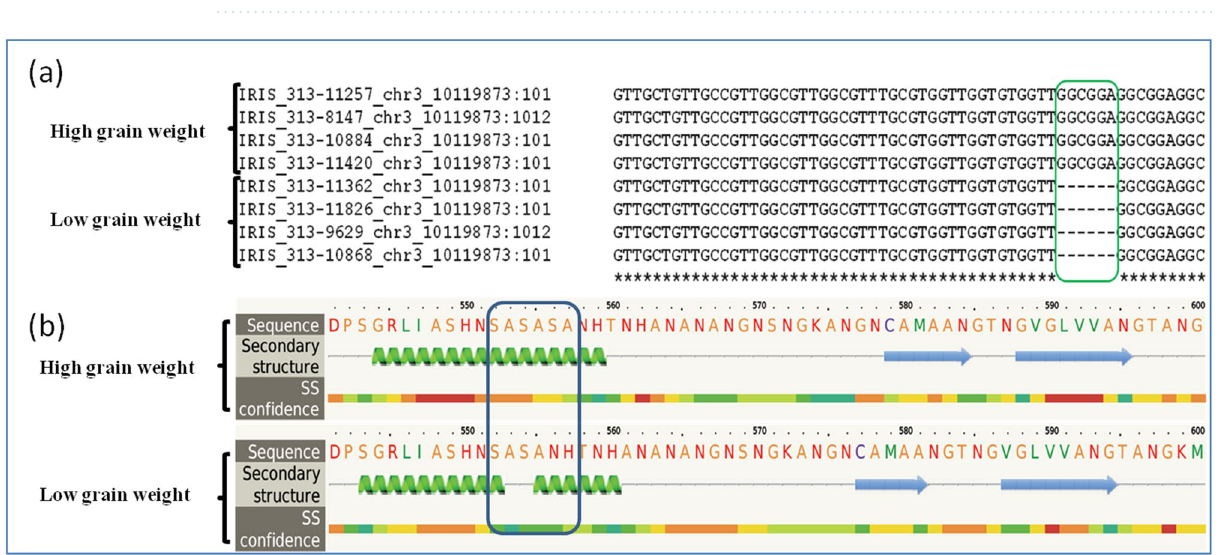
Figure 8. Sequence variation between low and high grain weight genotypes for LOC_Os03g18130 under MQTL3.1 retrieved from 3 k rice genome project. ( a ) A six base pair deletion in the last exon of the gene in low grain weight genotypes and ( b ) two amino acids, alanine and serine deleted in amino acid coding sequence which led to interruption of secondary structure (α-helix) of asparagine synthetase b protein in low grain weight